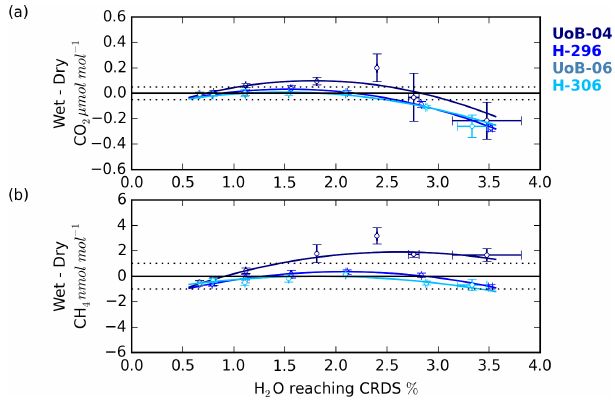
Figure 9. The (a) CO 2 and (b) CH 4 change in the wet–dry sam- ple treatment difference with sample water content for cylinders UoB-04 (515.3µmolmol − 1 CO 2 and 2585nmolmol − 1 CH 4 ), H- 296 (406.6µmolmol − 1 CO 2 and 1947nmolmol − 1 CH 4 ), UoB-06 (384.8µmolmol − 1 CO 2 and 1975nmolmol − 1 CH 4 ) and H-306 (372.5µmolmol − 1 CO 2 and 1776nmolmol − 1 CH 4 ). Error bars are the larger of either the standard deviation of the mean difference or the uncertainties of the two sample types added together in quadra- ture.